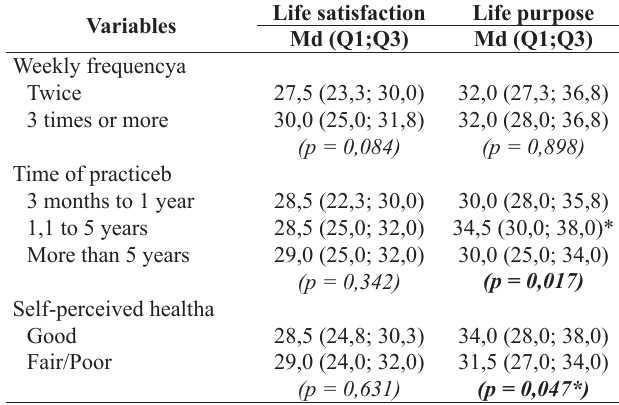
Table 4. Comparison between purpose in life and life satisfaction of the elderly who practice physical exercises according to self-per- ceived health and related to the practice of physical exercise. Marin- gá, Paraná, Brazil, 2018.